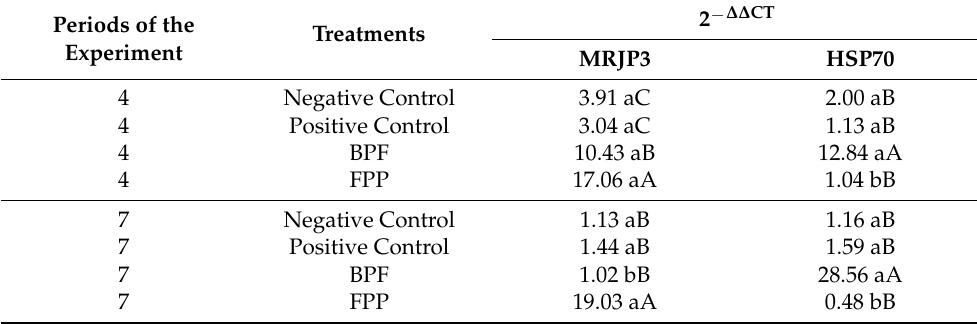
Table 3. Variable 2 −ΔΔCT with the unfolding between the MRJP3 and HSP70 proteins, and between the treatments.